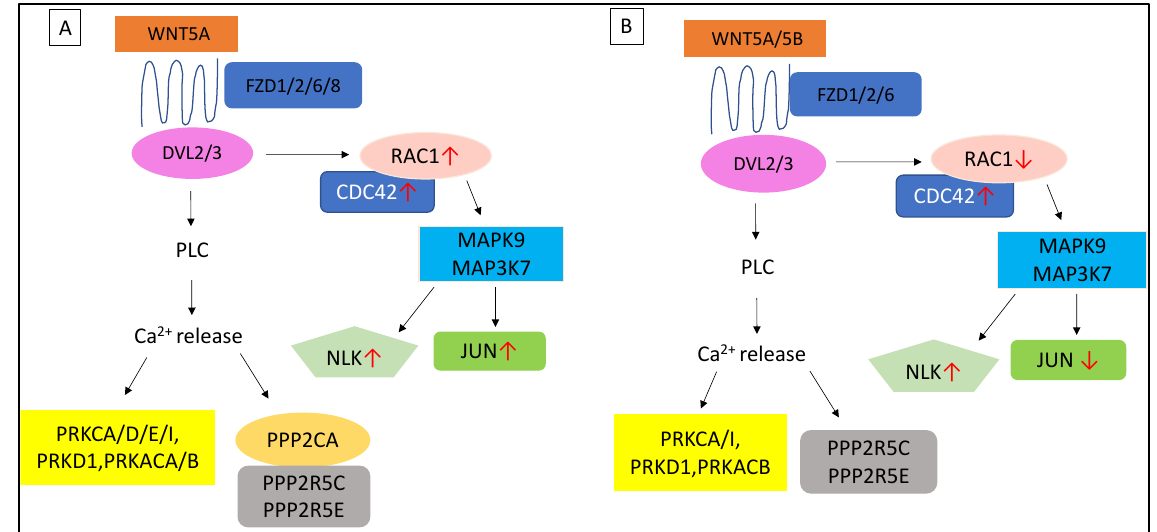
Figure 10. Non-canonical Wnt pathways in ( A ) AM-MSCs and ( B ) WJ-MSCs after osteogenic induction. Symbol ↑ and ↓ represent upregulation and downregulation, respectively. PLC: Phospholipase C.